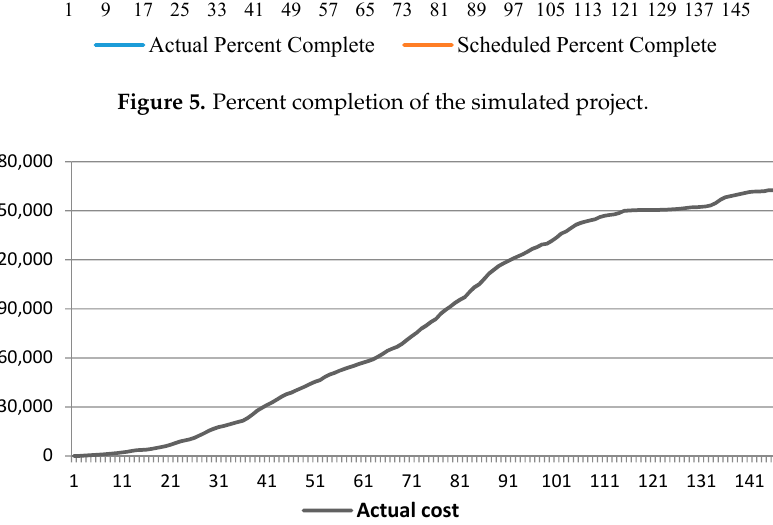
Figure 6. Actual cost S-curve. •